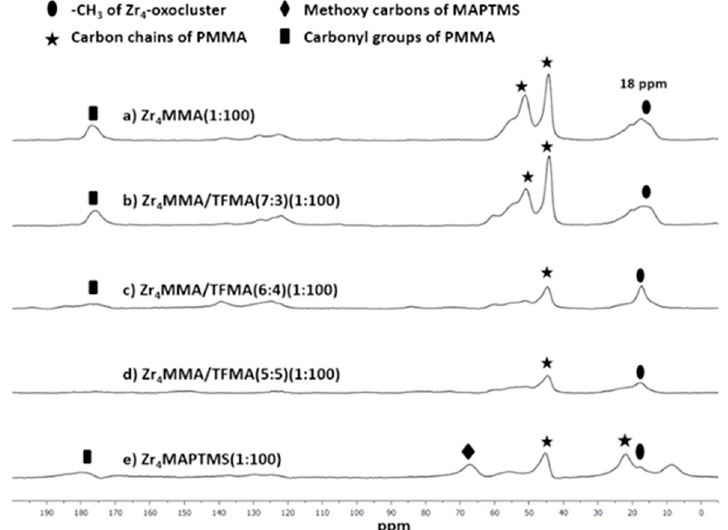
Figure 4. 13 C SS-NMR (400 MHz) of the following hybrids: ( a ) Zr 4 MMA(1:100), ( b ) Zr 4 MMA/TFMA(7:3)(1:100), ( c ) Zr 4 MMA/TFMA(6:4)(1:100), ( d ) Zr 4 MMA/TFMA(5:5)(1:100), ( e ) Zr 4 MAPTMS(1:100).